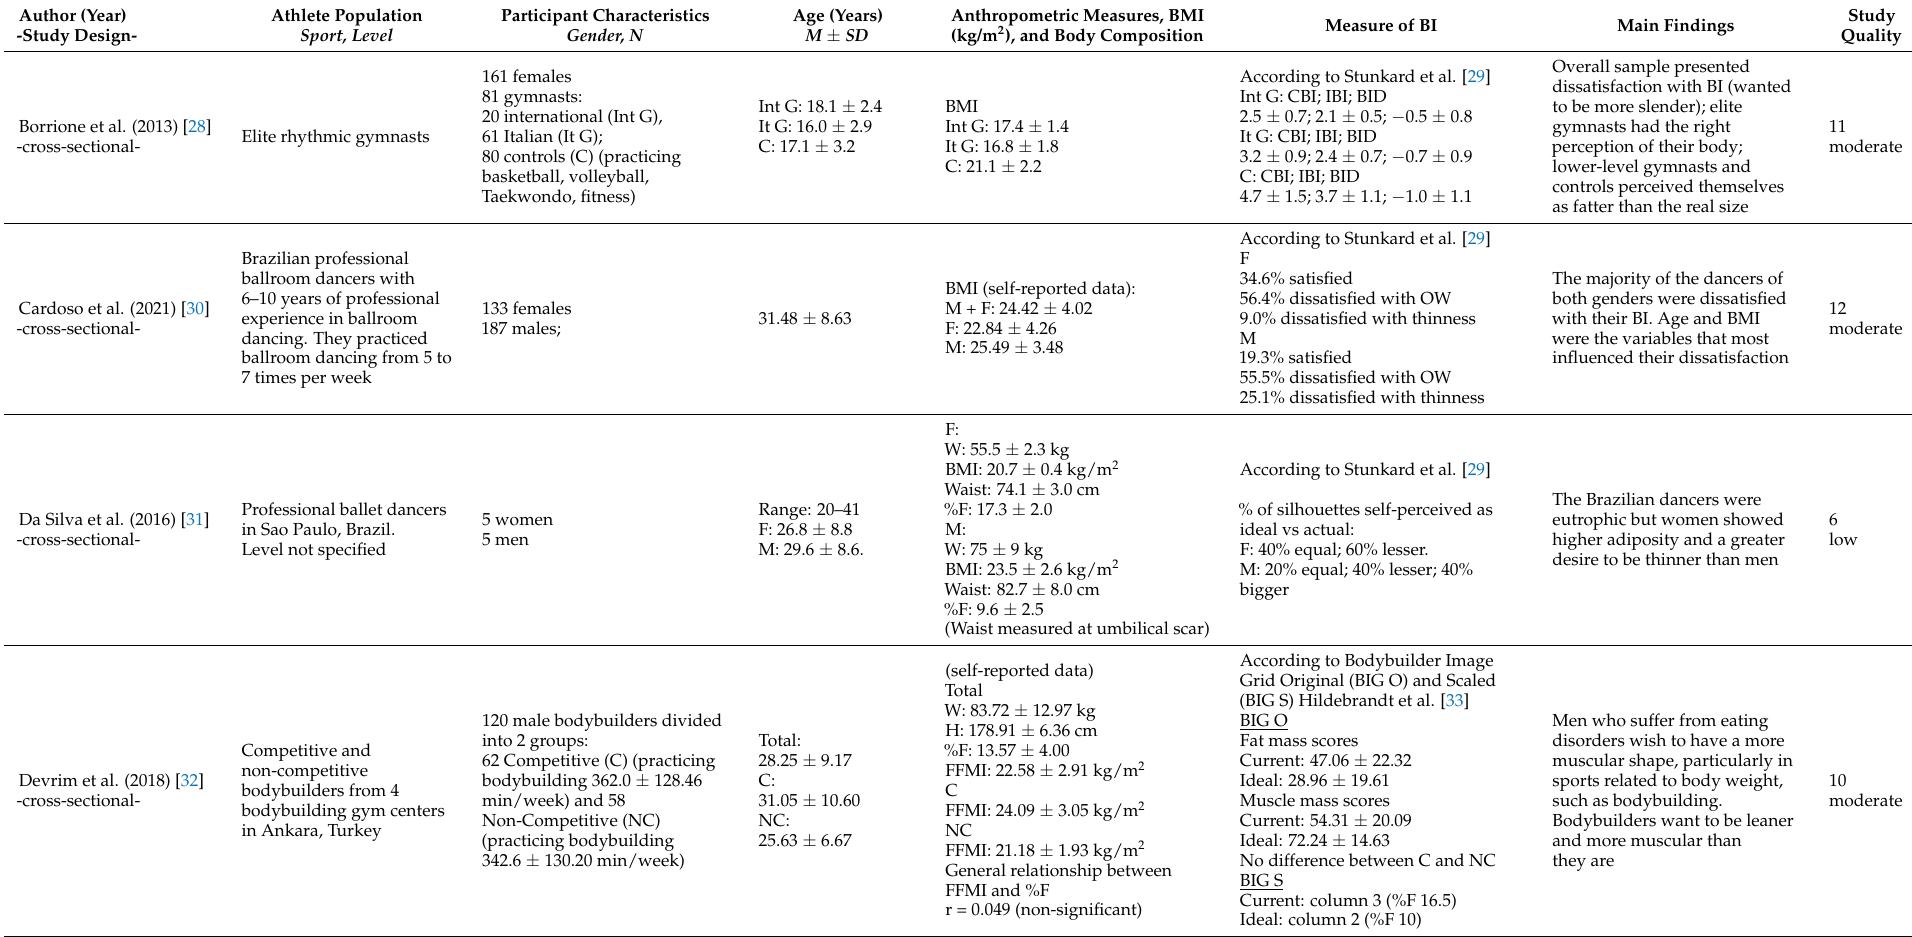
Table 1. Summary of selected studies included in the systematic review: sports information, anthropometric profile, and body image assessment of the samples.